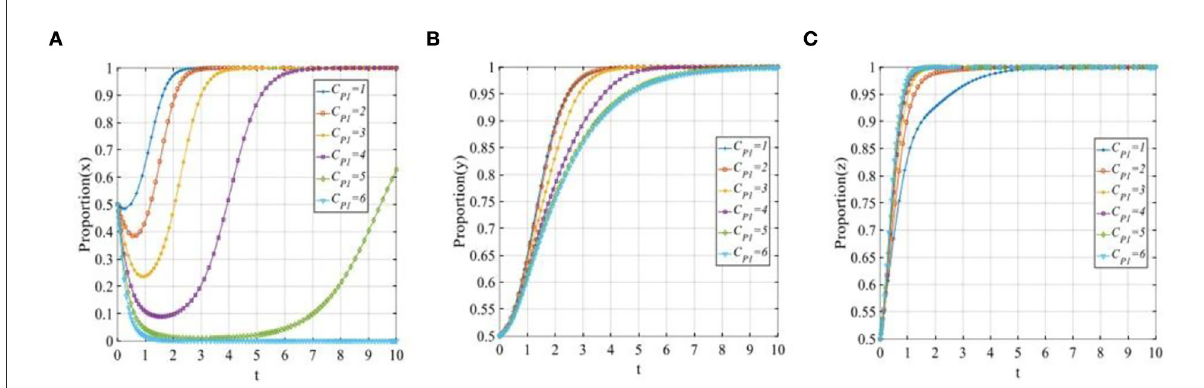
FIGURE7 The sensitivity analysis of the cost of P2P lending platforms’ “positive disposal” strategy when C P 1 = 1, 2, 3, 4, 5, 6. (A) The sensitivity of P2P lending platforms; (B) The sensitivity of investors; and (C) The sensitivity of financial